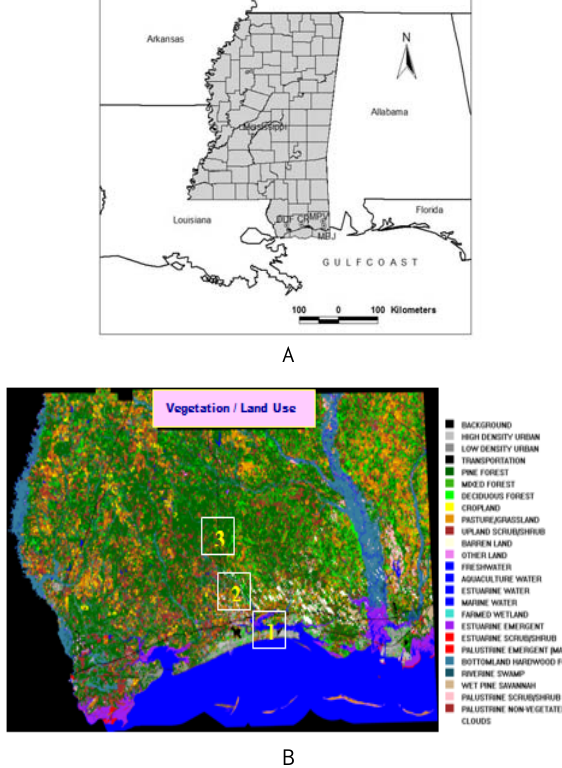
Figure 1 : Location of the study region (a) and Vegetation / Land use of the Mississippi Gulf coast region (b). The experimental locations are Sea bee base (1), Harrison (2) and Wiggins